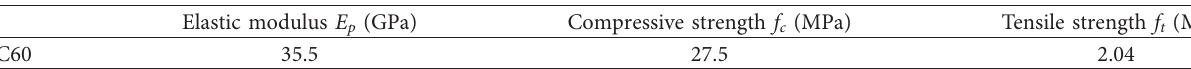
Figure 6: Schematic diagram of the utility tunnel model. Table 3: Concrete properties.